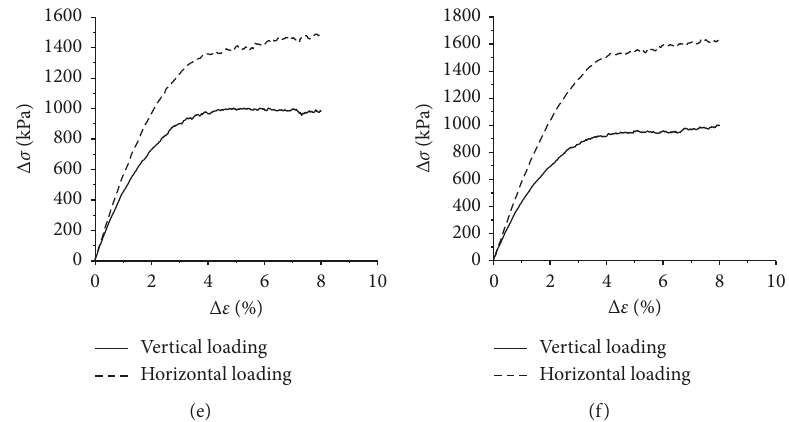
Figure 7: Curves of stress-strain relationship of three samples: (a) samples A1 and A2; (b) samples B1 and B2; (c) samples C1 and C2; (d) samples D1 and D2; (e) samples E1 and E2; (f) samples F1 and Table 7: Macromechanical parameters of samples. Sample number